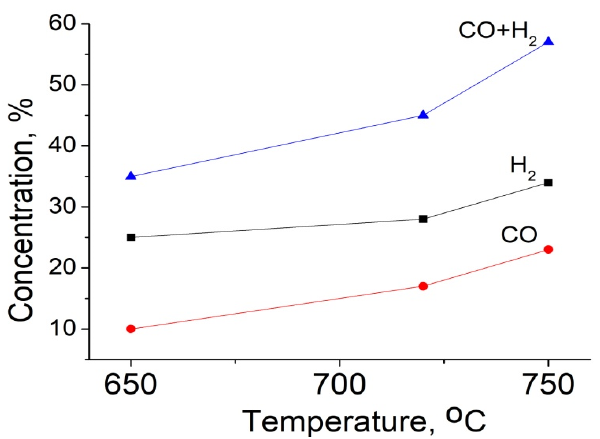
Figure 7. Temperature dependence of product concentrations in ATR of ethylacetate over the monolithic honeycomb catalyst comprised of FeCrAl gauzes loaded with NiRu/CeZrPrO on mesoporous